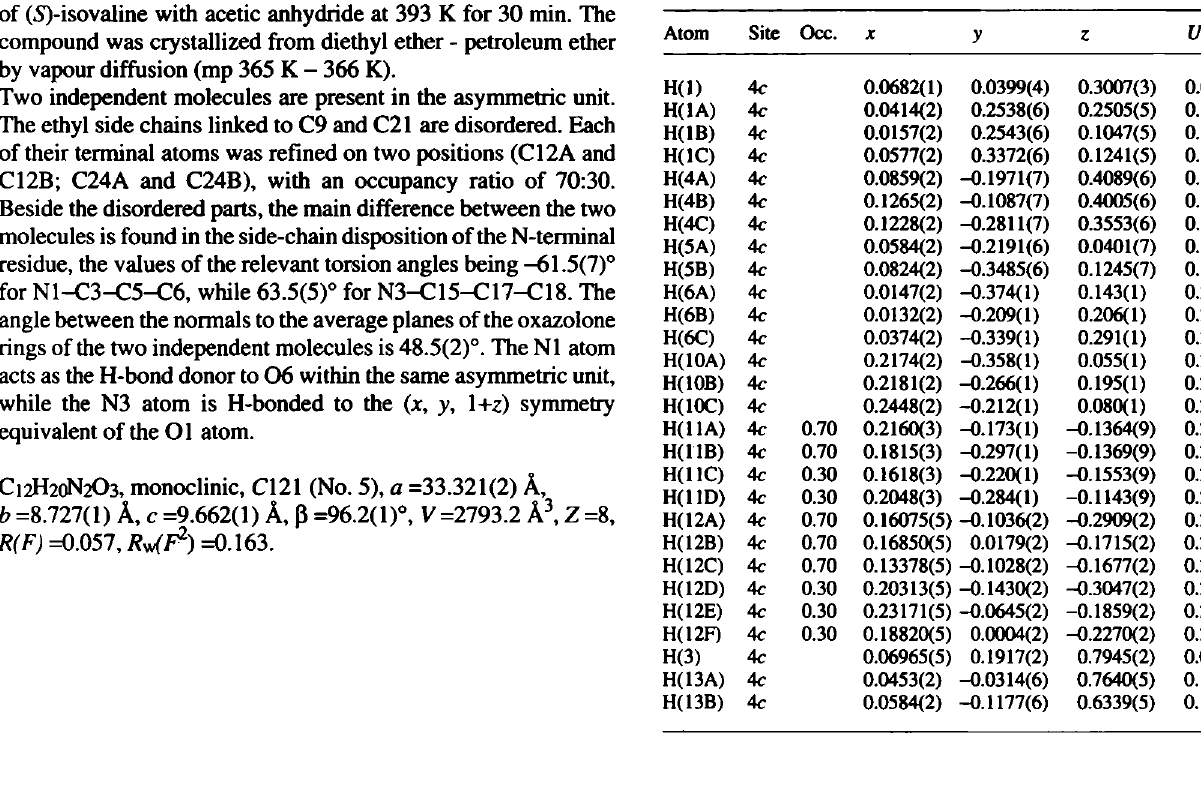
Table 2. Final atomic coordinates and displacement parameters (in